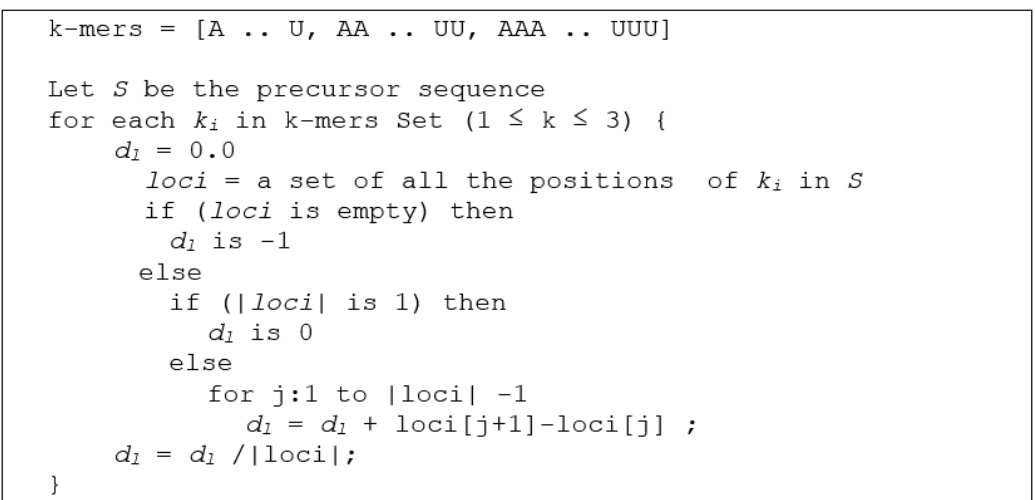
Figure 2. The description of the algorithm calculating the k-mer location distance features. |loci| depicts the number of elements in the set; loci[i] refers to the ith element in the set.